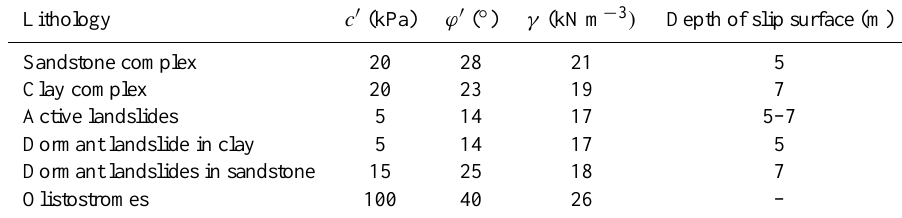
Table 2. Geotechnical properties of the lithotypes cropping out at Castelfranci. Lithology c 0 (kPa) ϕ 0 ( ◦ ) γ (kNm − 3 ) Depth of slip surface (m) Sandstone complex 20 Clay complex Active landslides Dormant landslide in clay